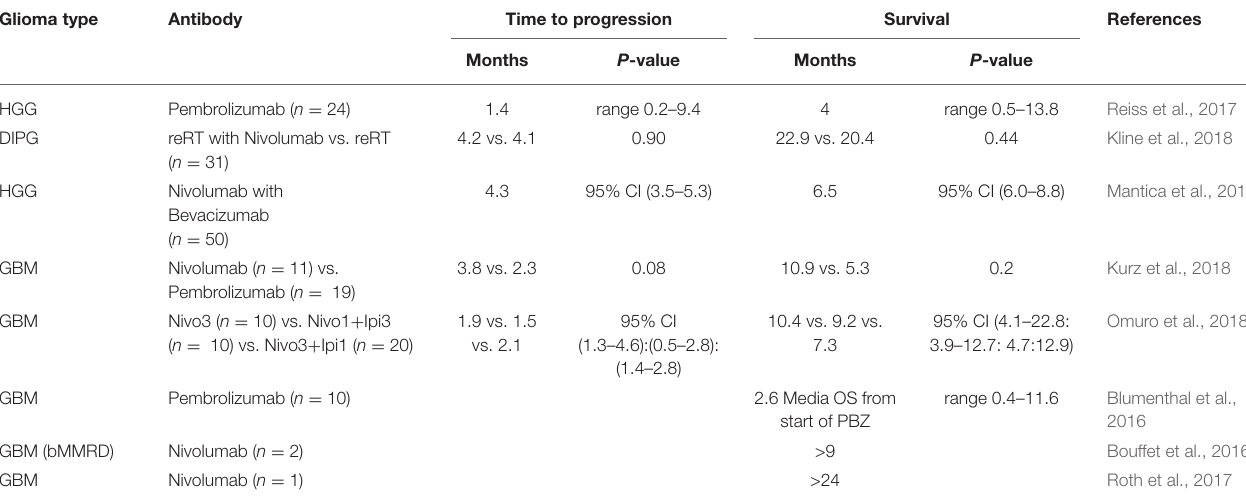
TABLE 3 | The therapeutic effects of PD-1 antibody in glioma patients. Glioma